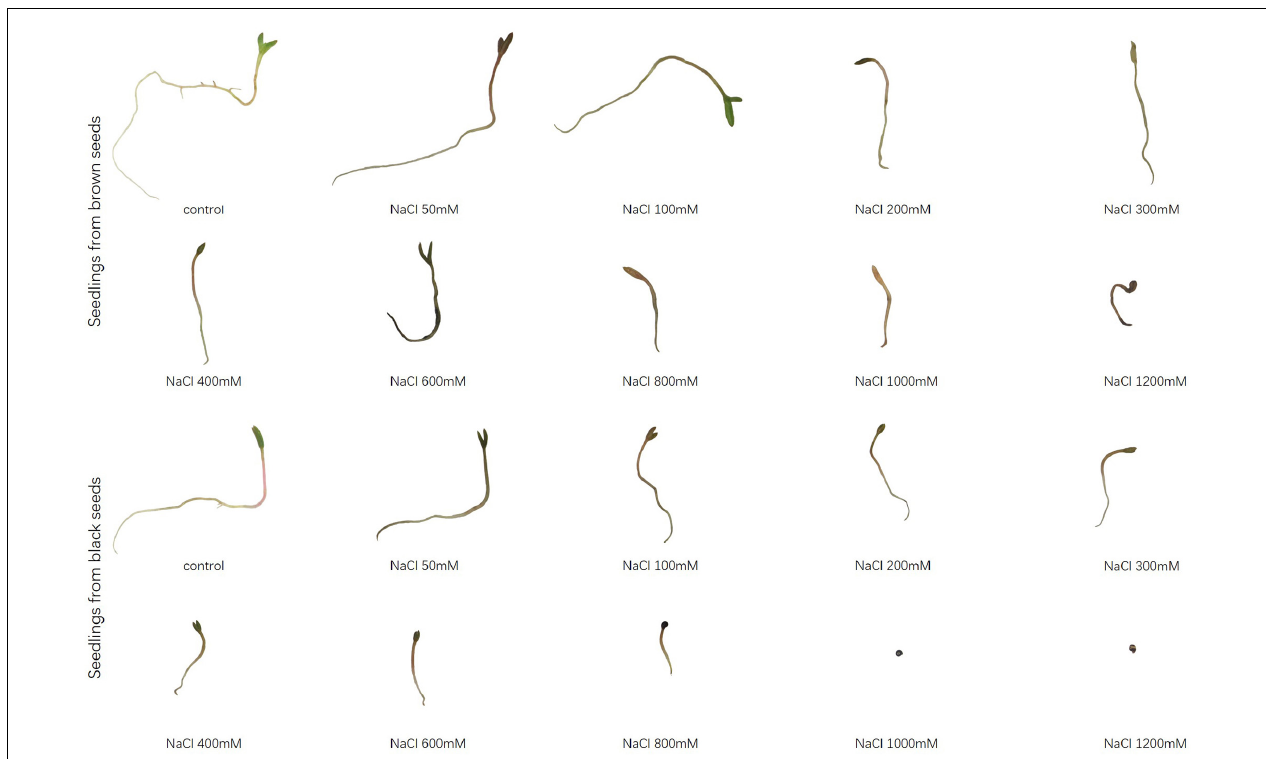
FIGURE 6 | Radicle elongation of seedlings grown from dimorphic seeds of S. salsa after 20 days of incubation under different concentrations of NaCl.